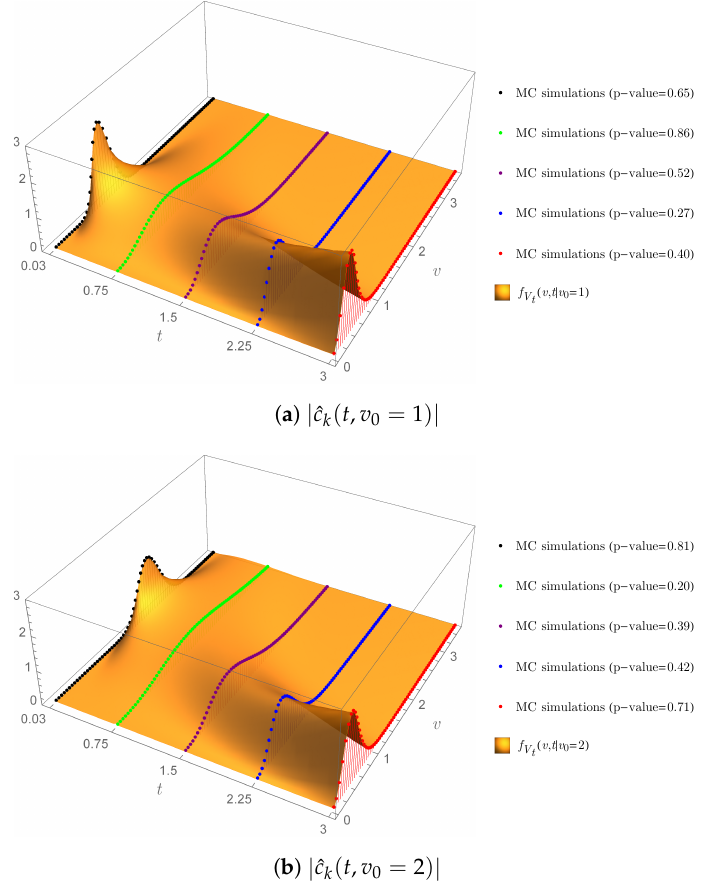
( v , t | v ) computed from our explicit Formula (31), against the corre- Figure 10. The graphs of f V 0 t sponding histograms of the random samples generated from (19) based on MC simulations for t = 0.03,0.75,1.5,2.25,3, along with the p -values in parentheses obtained from the K-S tests with a significant level of 0.1 in Example